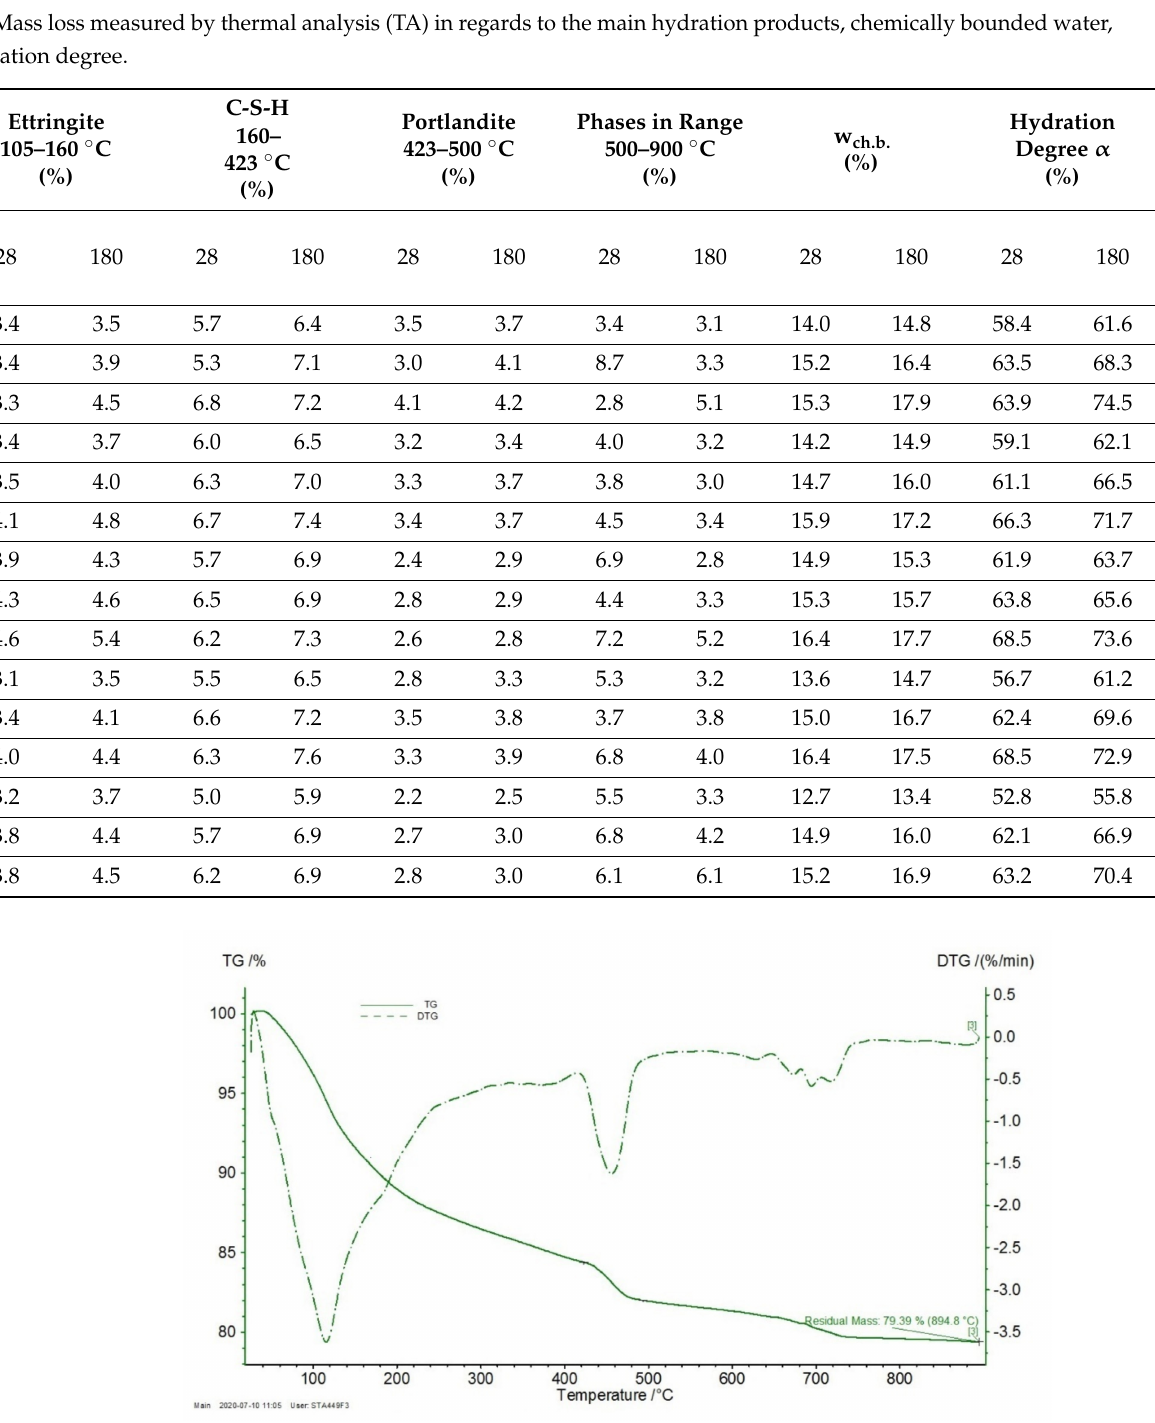
Figure 17. Thermogravimetric (TG)/DTG curves of the NZ15.0_0.3